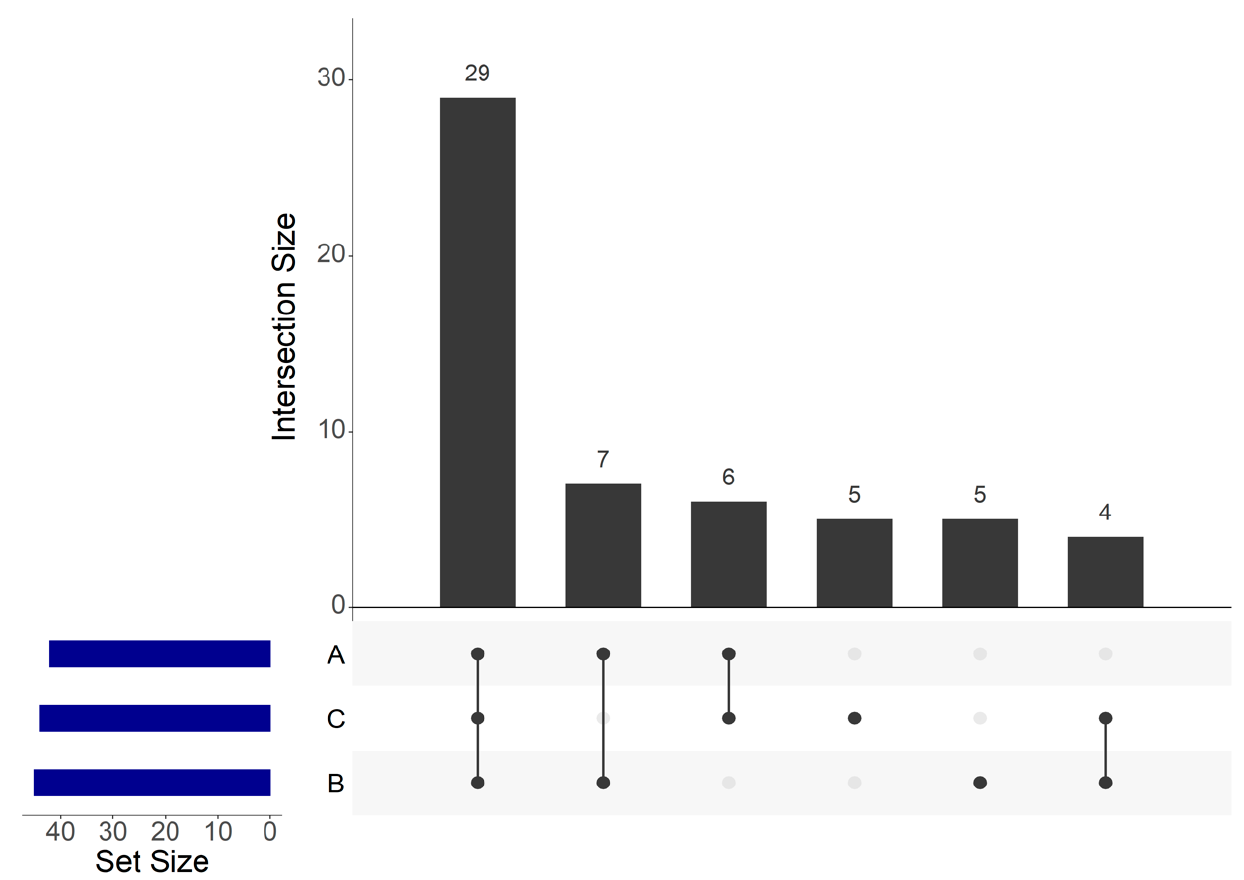
Figure 5. UpSet plot of shared operational taxonomic units (OTUs) identified within cold-smoked salmon vacuum-packed products according to the food processing factory.